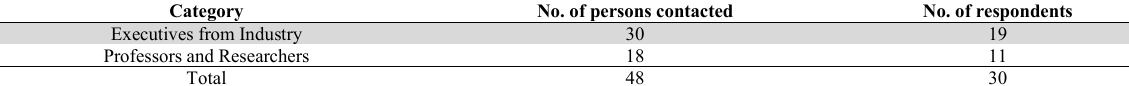
Distribution and Composition of Panelists